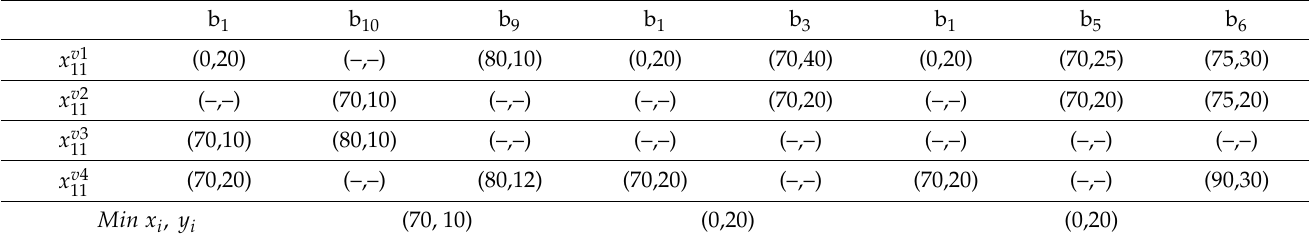
Record the vertices of all free spaces to draw the skyline polygon, as shown in Table 8. Select preferred Origin to the Camel or box b i .